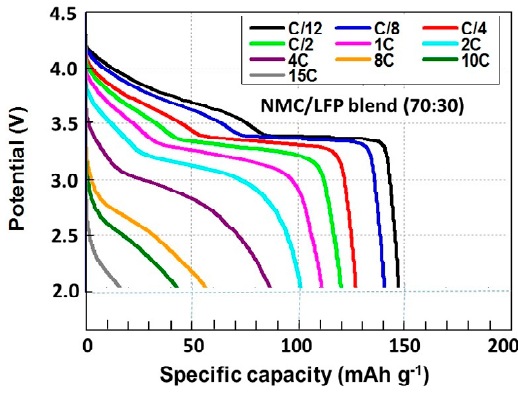
Figure 8. Discharge profiles (5th cycle) as a function of the C-rate of Li-coin cell with a NMC–LFP (70:30) blend positive electrode. Electrochemical tests were carried out in the potential range 2.0–4.2 V vs. Li 0 /Li + .